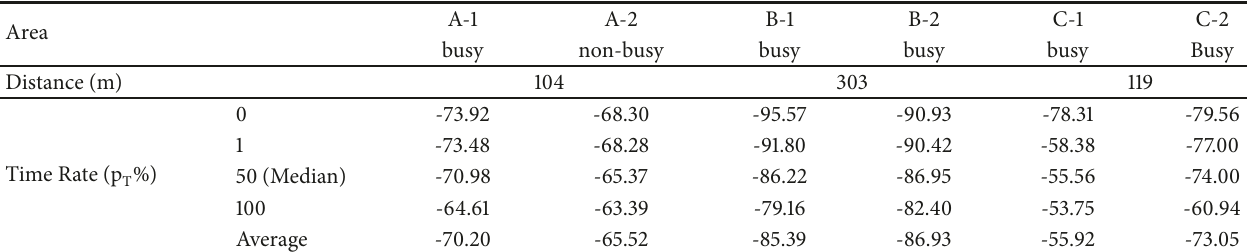
Table 3: RSRP measurements in busy time and nonbusy time.